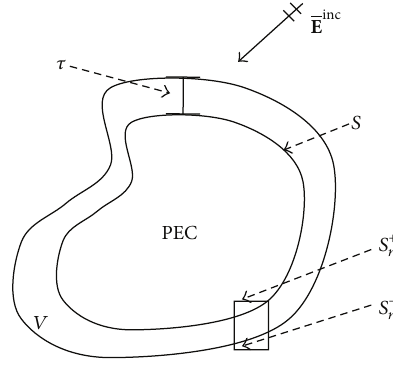
Figure 1: A PEC target coated by LHM.